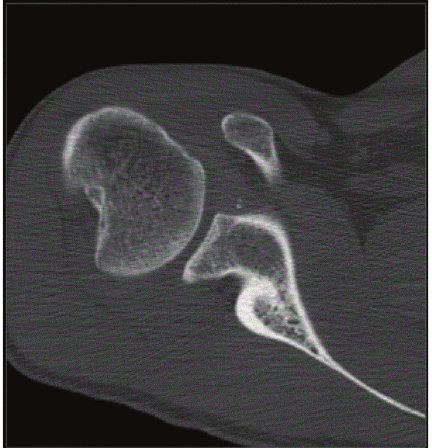
Figure 2: CT scan which demonstrates a large Hill-Sachs